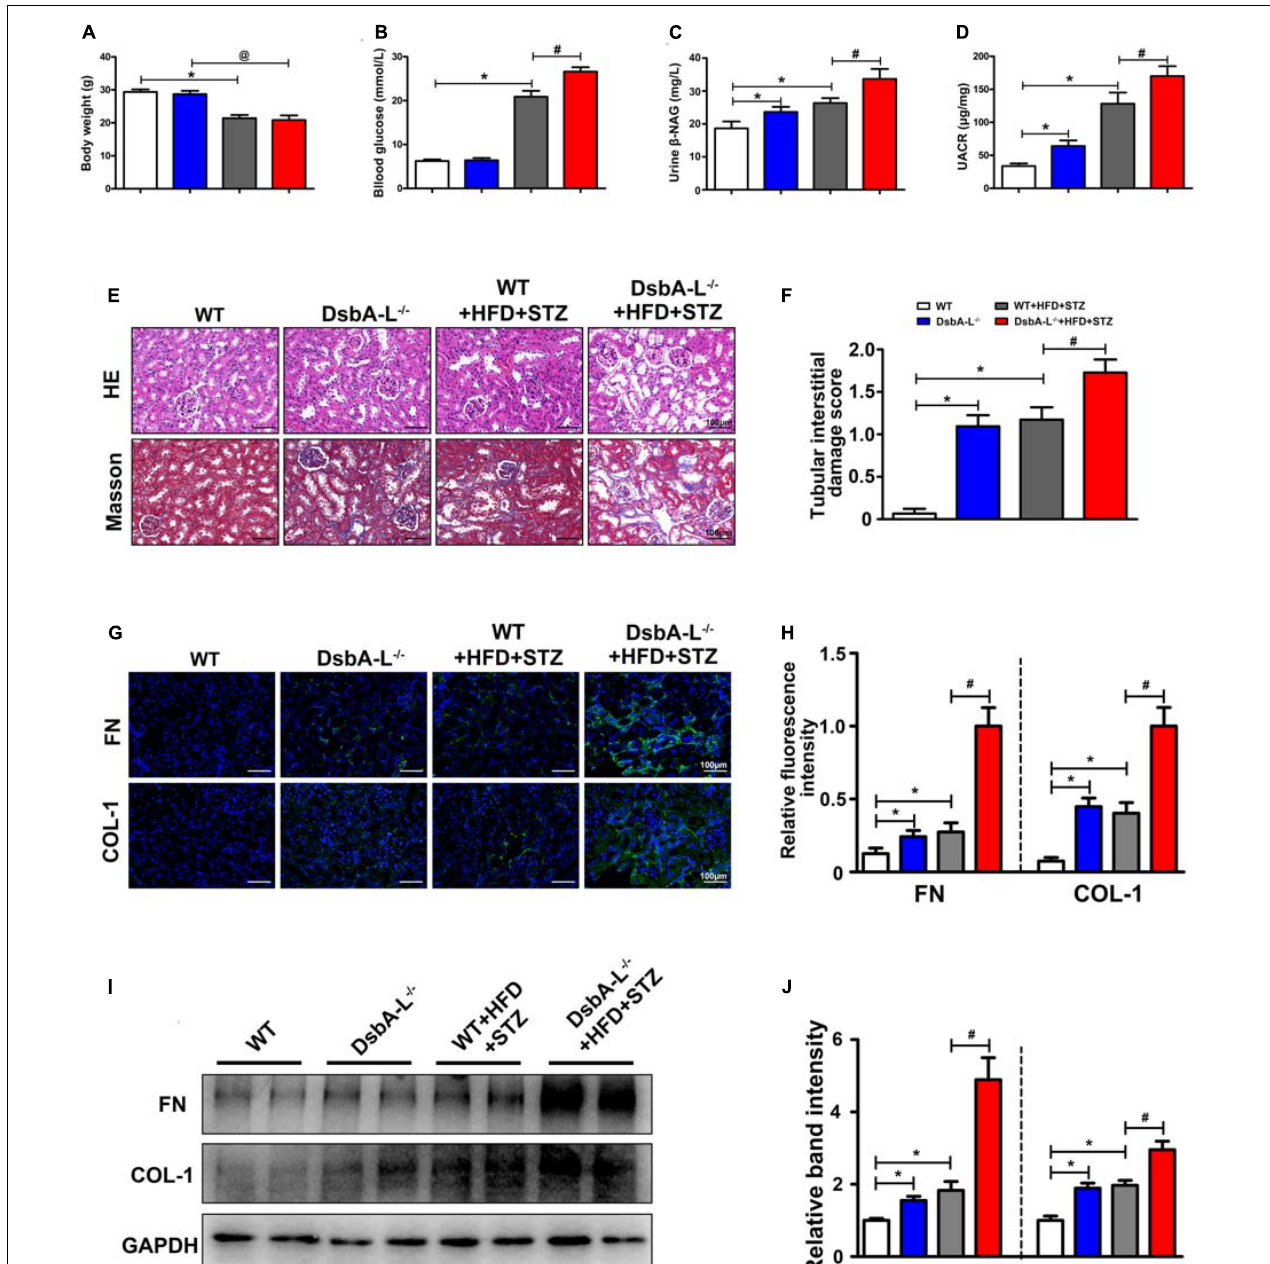
FIGURE 1 | Pathophysiological changes and renal fibrosis in diabetic DsbA-L-deficient mice. Body weight (A) , blood glucose (B) , urine β -NAG (C) , and UACR (D) in each group. (E) HE and Masson staining were used to detect pathological changes in the kidneys. (F) The degree of tubular injury as assessed by the tubular interstitial damage score. (G,H) IHF staining with anti-fibronectin antibody (upper panel) and anti-collagen 1 antibody (lower panel) shows the renal fibrosis. (I,J) Western blot analysis reveals the expression of FN and COL-1. The values are the mean ± SD. n = 3/group. * p < 0.05 compared with the control group; # p < 0.05 compared with the diabetic